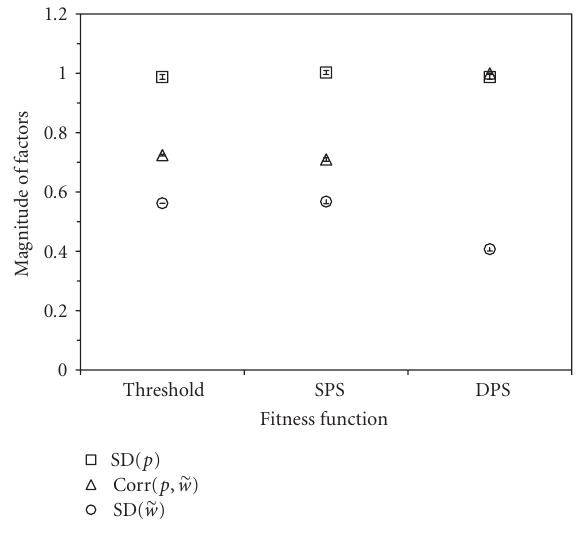
Figure 2: The three factors contributing to performance improve- ment compared over 1 round of selection across three fitness func- tions using numerical simulations: threshold selection, stochastic proportionate selection (SPS), and deterministic proportionate selection (DPS). Each sample consisted of 100 simulated individuals with performance values drawn from a normal distribution with mean = 100, SD = 1. Markers show means, and bars show ± standard error over 100 samples. (Note that error bars are too small to extend beyond marker symbols.)